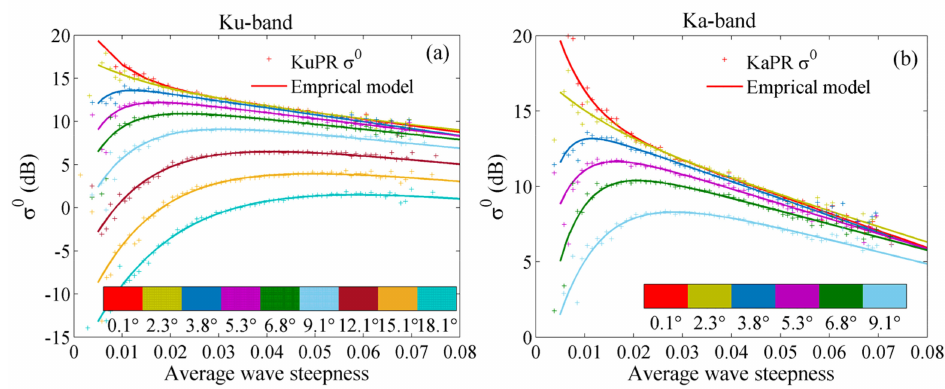
Figure 13. Mean values of binned ( a ) KuPR σ 0 , ( b ) KaPR σ 0 as functions of average wave steepness ( δ a ) for selected incidence angles. Solid lines are the empirical model functions.